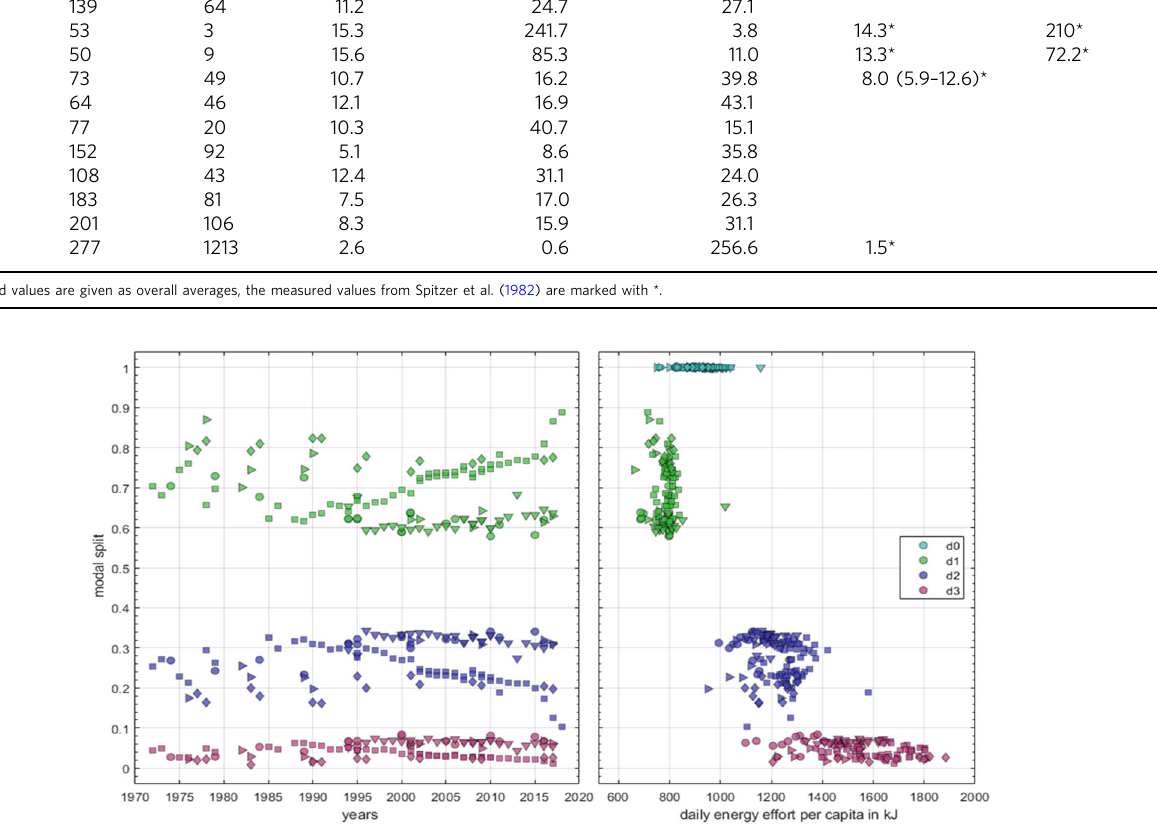
Fig. 9 Modal split and travel energy. Modal split over survey years ( a ) and corresponding daily energy effort per capita ( b ) of 1-, 2- & 3 + modal behaviour (marked by d 1, d 2, d